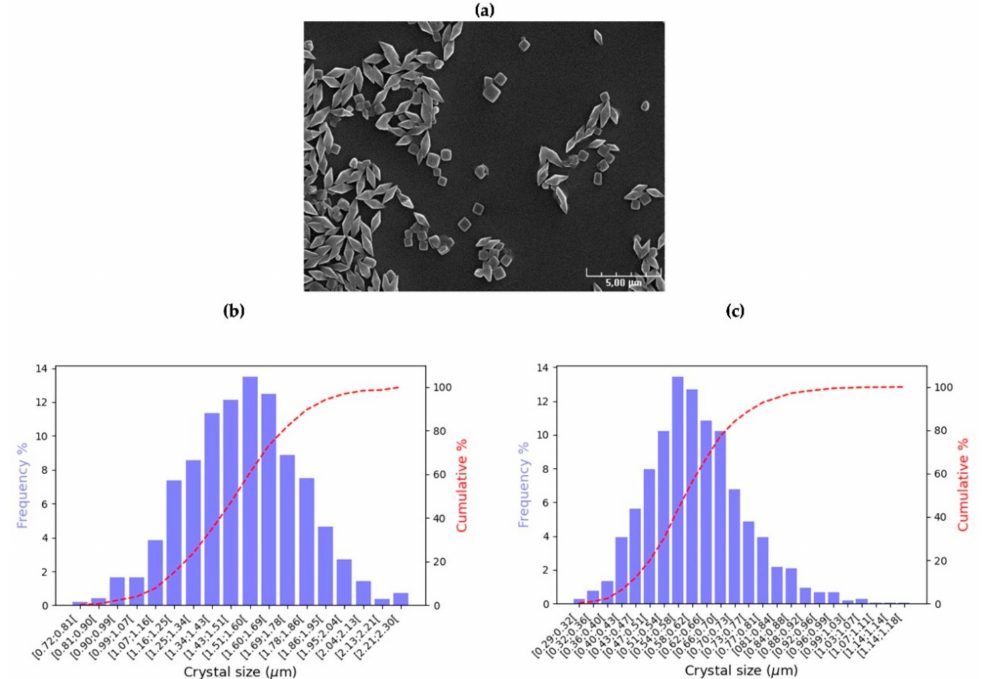
Figure 4. ( a ) SEM image of the BLB1 purified crystals. ( b , c ) graphs representing the size distribution in terms of frequency, along with the cumulative percentage of the bipyramidal height for the bipyramidal crystals and the cubic size of the cubic